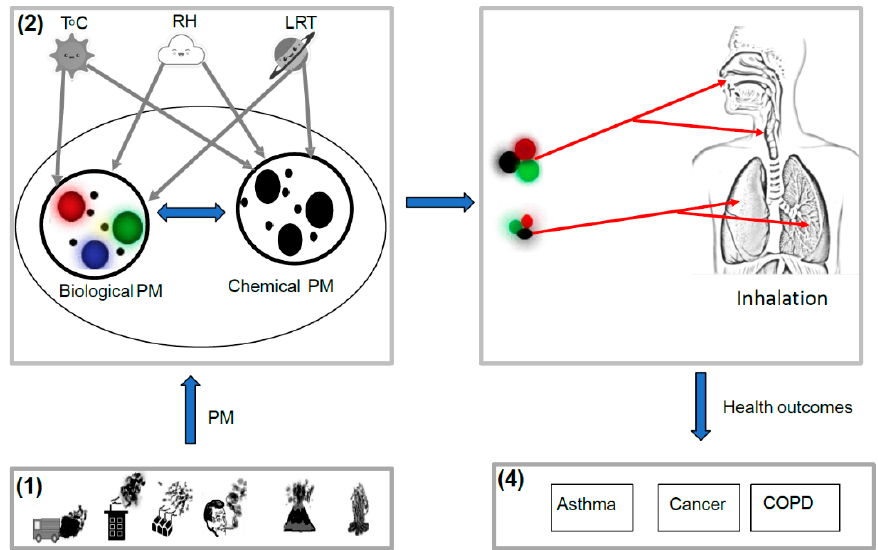
Figure 1. A schematic representation of the complex relationships between biological and chemical components of particulate matter (PM). ( 1 ) The sources of airborne PM; ( 2 ) the interaction of chemical and biological components of PM through the influence of T °C (temperature), RH (relative humidity), and LRT (long range transport); ( 3 ) routes of exposure to the mixture of PM 2.5 (particulate matter with aerodynamic diameter less than 2.5 micrometers) that can enter the lungs and PM 10 (particulate matter with aerodynamic diameter less than 10 micrometers) that are trapped in the nasopharyngeal from chemical and biological origins; and ( 4 ) possible health outcomes (Chronic Obstructive Pulmonary Diseases (COPD), asthma, and cancer).